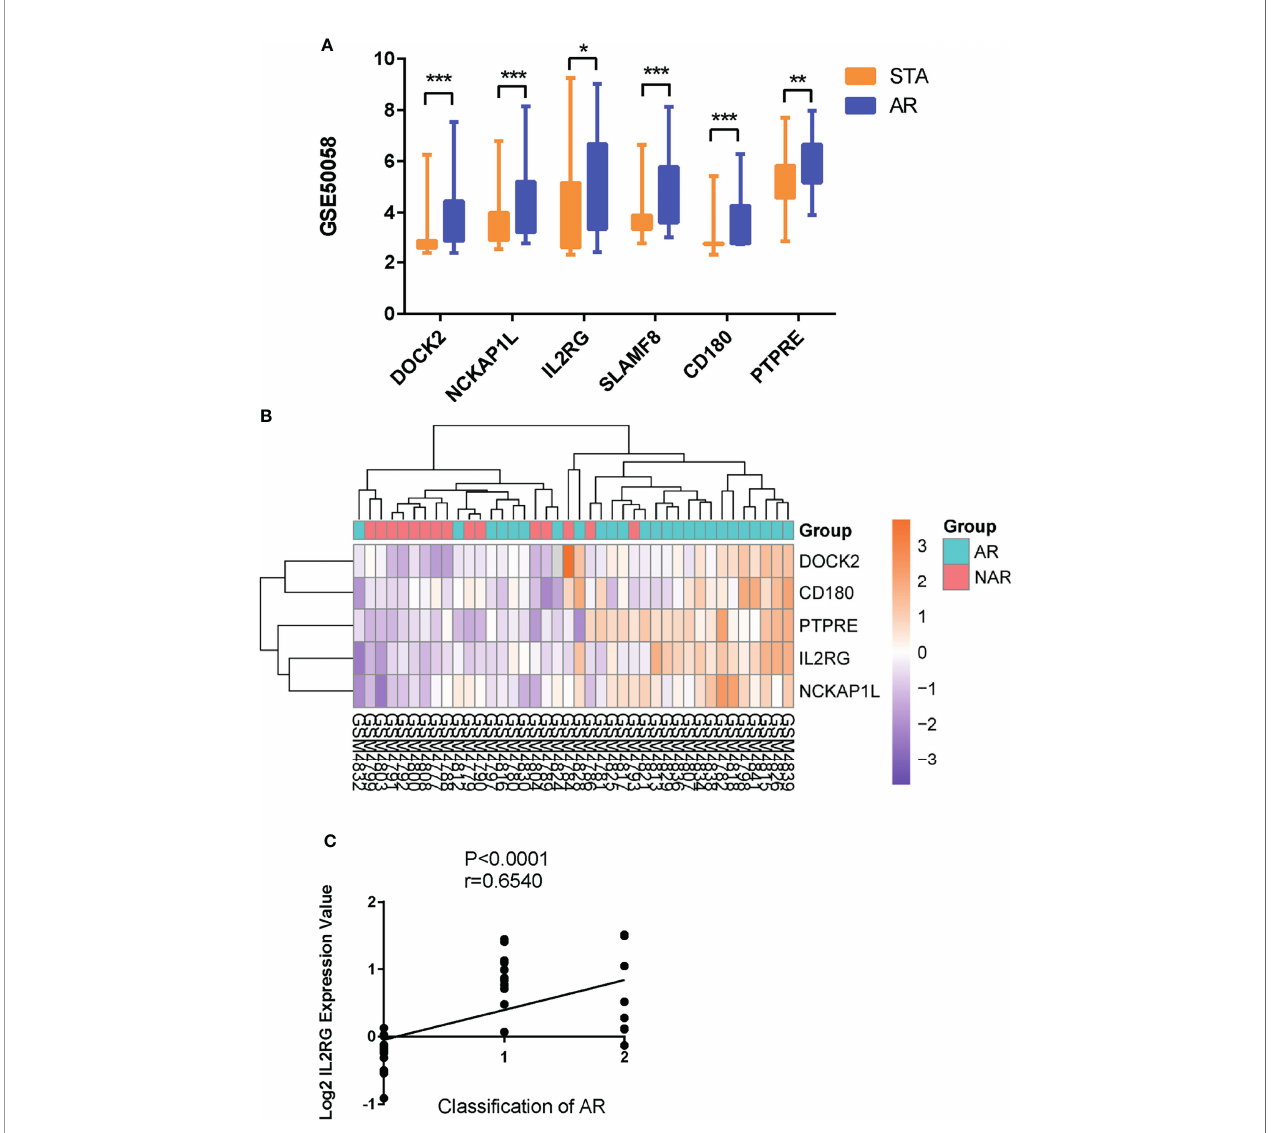
FIGURE 4 | GEO and clinical validation. (A) Expression levels of DOCK2, NCKAP1L, IL2RG, SLAMF8, CD180, and PTPRE were signi fi cantly upregulated in the renal allograft biopsy of AR patient in dataset GSE50058. (B) The clustering of fi ve hub genes in heatmap of dataset GSE343. (C) Correlation between the expression of IL2RG in AR with the Banff pathological grading of transplanted kidney. STA, stable patients; AR, patient with acute rejection. * p < 0.05, ** p < 0.01, *** p <